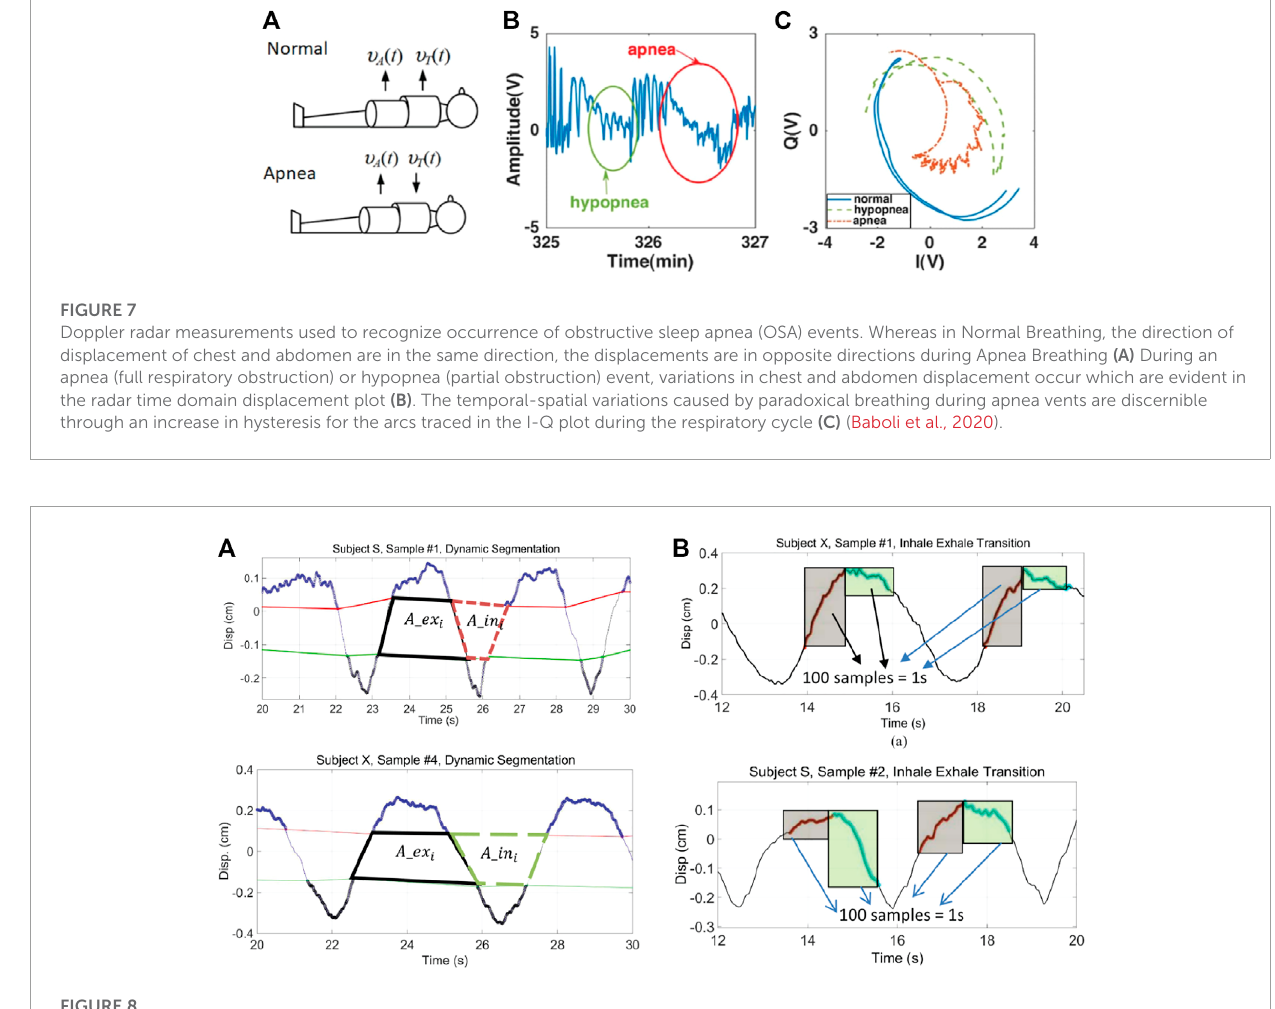
FIGURE 8 Examples of time series feature extraction for Doppler radar-based subject identity authentication. Breathing diversity is apparent for two different participants (upper vs. lower plots) as illustrated through their inhale/exhale area ratios (A) and variations in dynamics during the transition from inhale to exhale (B) (Rahman et al.,